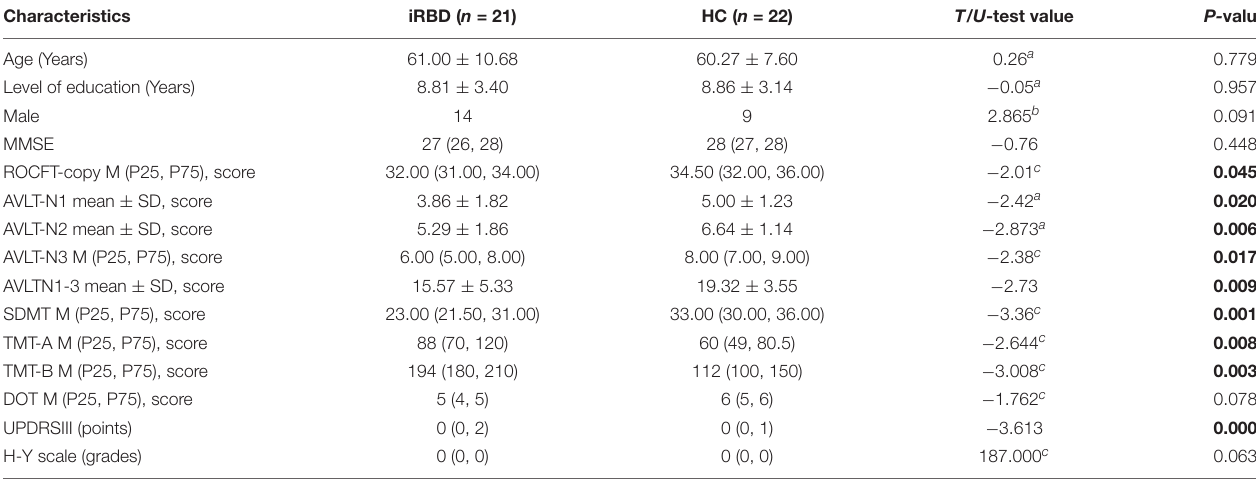
TABLE 1 | Demographic and clinical characteristics of the subjects.